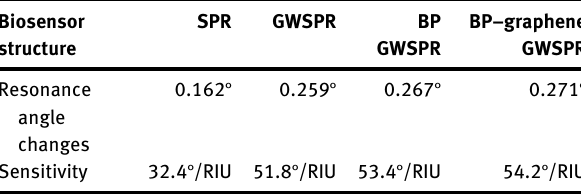
Table  : Resonance angle changes and sensitivities of four bio- sensors when the RI of sensing target is  .  RIU.